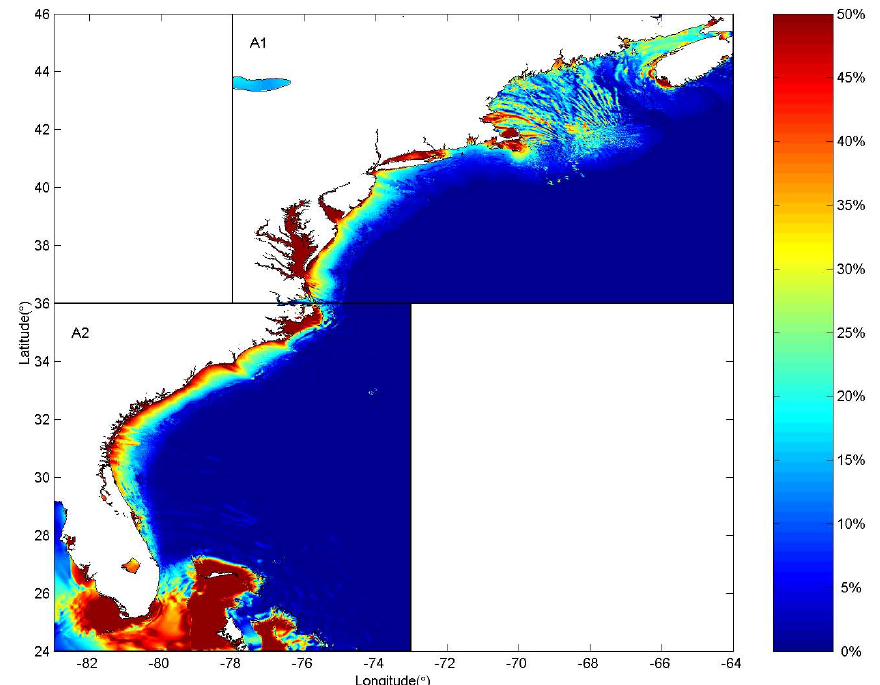
Fig. 25. Reduction in computed maximum water surface elevations due to bottom friction. The colour scale is set between 0 and 50%. The values are computed as | ζ max . nonfric − ζ max . fric | / | ζ max . nonfric |× 100%, where ζ max . nonfric is the maximum water surface elevation predicted without seabed friction and ζ max . fric is that with seabed